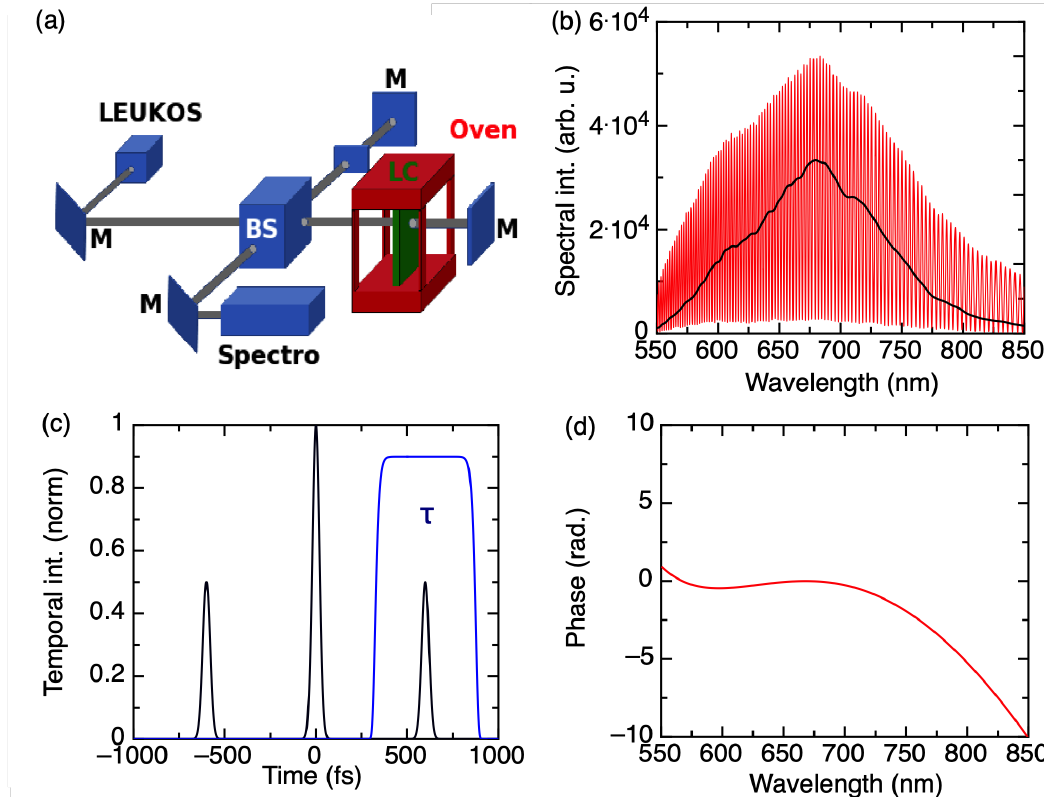
Figure 1. ( a ) Experimental set-up: a super-continuum laser source (Leukos) seeds a Michelson interferometer for Spectral Domain Interferometry. A polarizer (P) sets the polarization direction. The LC cell is placed in one arm, and eventually inside an oven (HC photonics corp.) for thermotropy analysis. (F: long-pass filter with λ cutof f = 500 nm, D: short-pass dichroic mirror λ cutof f = 950 nm, M: mirror, BS: beam splitter, C: compensation plates). ( b ) Typical one-arm (black) and interference (red) spectra. ( c ) Fourier Transform of the acquired spectrum (black) and applied temporal filter (blue). ( d ) Measured spectral phase from FTSI analysis (see